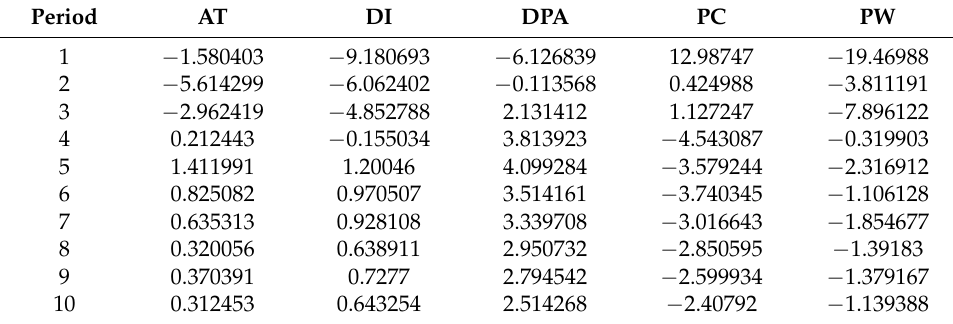
Table 9. Impulse response results of WC/$10 4 GDP in Jiangsu Province.